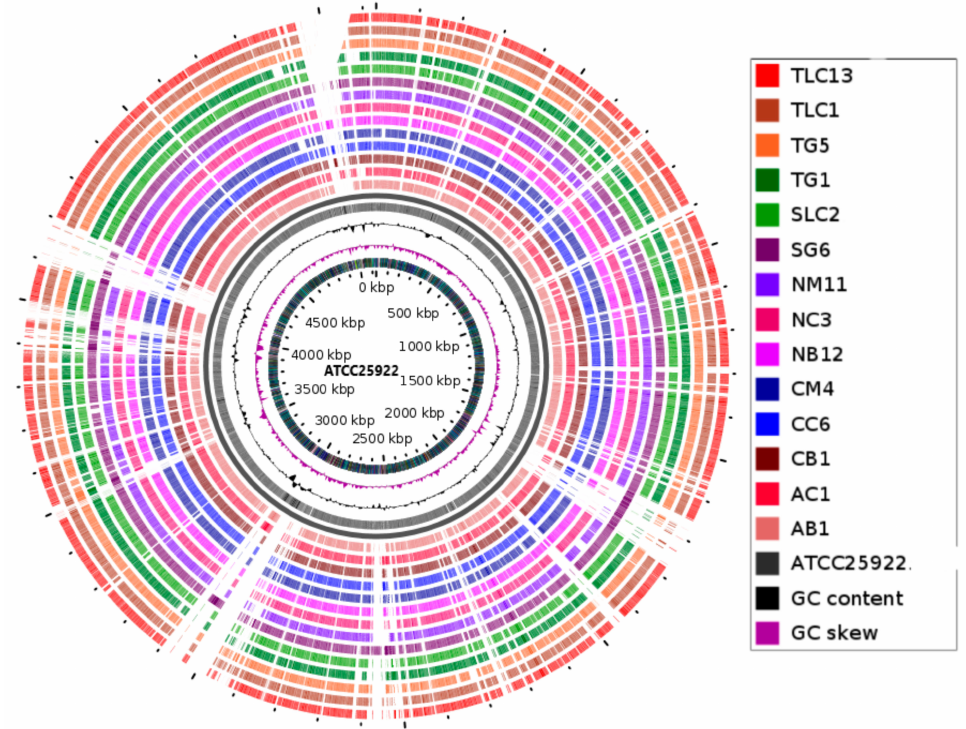
Figure 1. Comparative visualisation of the isolates ( n = 14) with the E. coli reference strain (ATCC25922, Accession number: CP009074). The map was constructed using the GView online server (https: // server.gview.ca / ). The concentric circles represent comparisons between ATCC25922 and, starting with the inner circle, genome assemblies from E. coli genomes (strain ID: AB1, AC1, CB1, CC6, CM4, NB12, NC3, NM11, SG6, SLC2, TG1, TG5, TLC1, and TLC13). Colour codes are given for each strain with a synteny identity, ranging from